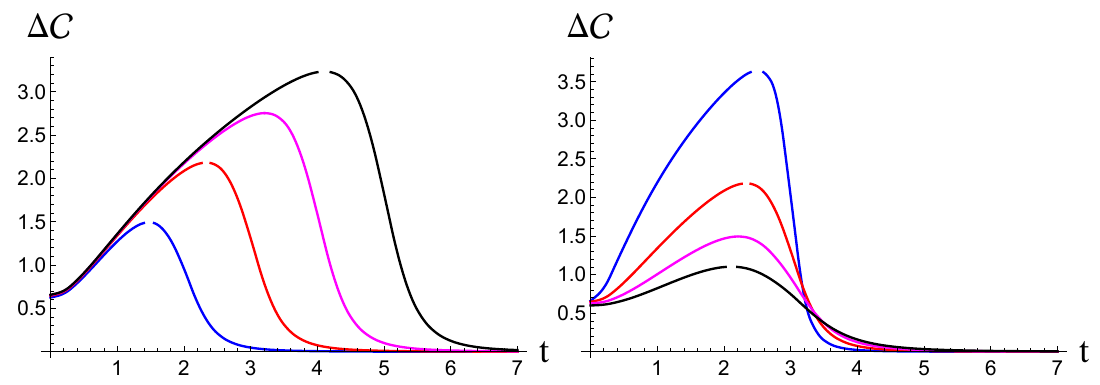
Figure 3 . On the left plot we show the time dependence of the (rescaled) complexity of the excitation (cid:1) C for interval x 2 ( (cid:0) ‘; ‘ ) and for (cid:11) = 0 : 5. Di(cid:11)erent curves correspond to di(cid:11)erent ‘ = 2 ; 3 ; 4 ; 5 for down to top. On the right plot the same for (cid:12)xed ‘ = 2 and (cid:11) = 0 : 25 ; 0 : 5 ; 0 : 75 ; 1 from down to